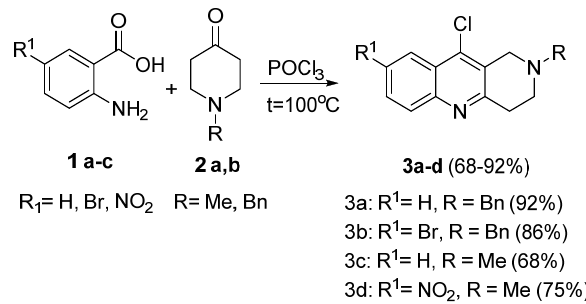
Figure 1. Biologically active derivatives of benzo[ b